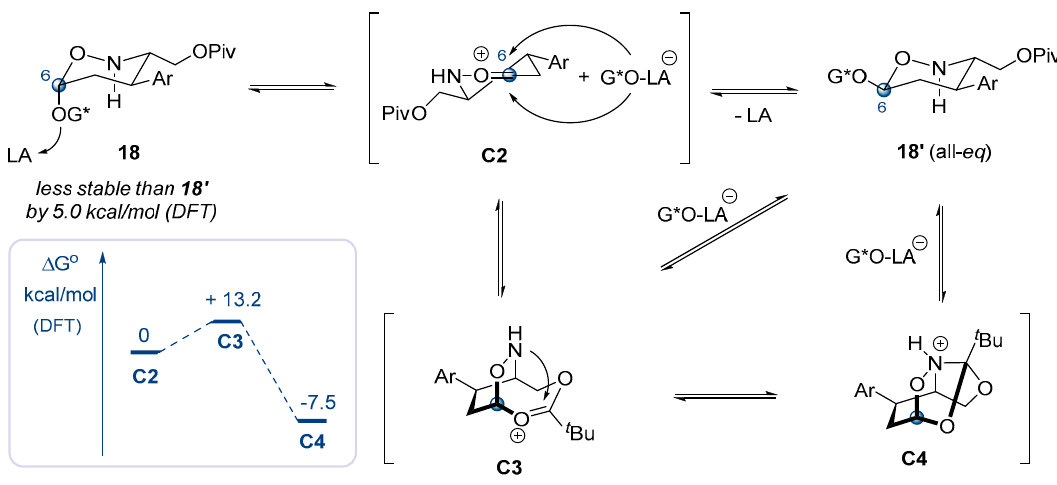
Scheme 7. Plausible mechanism of the epimerization at the C-6 position in 1,2-oxazine 18 . Ar − 4- methoxy-3-cyclopentyloxyphenyl, G*— trans -2-phenylcyclohexyl. DFT calculations: MN15/Def2TZVP (AcOH, smd), LA was not included in the